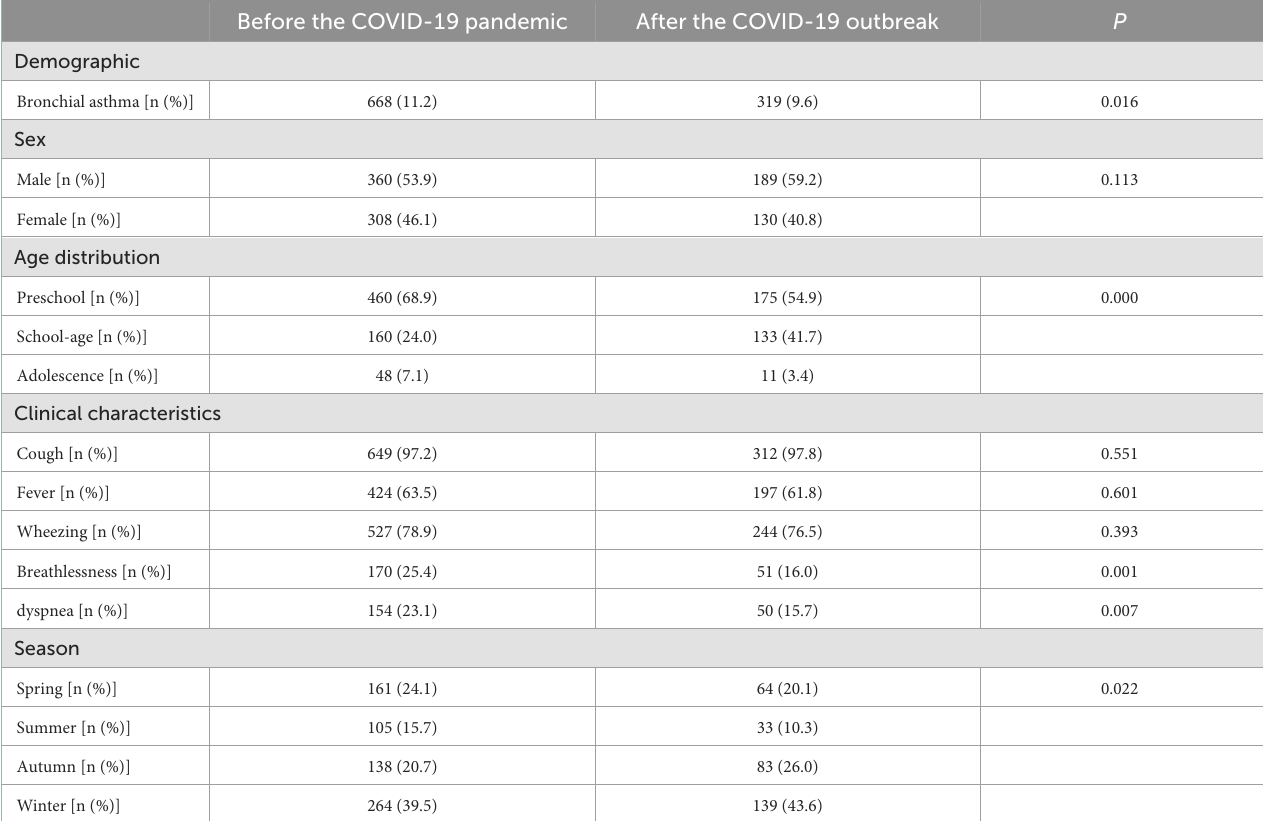
TABLE 1 Demographic and clinical characteristics of children hospitalized for bronchial asthma before and after the COVID-19 outbreak. Before the COVID-19 pandemic After the COVID-19